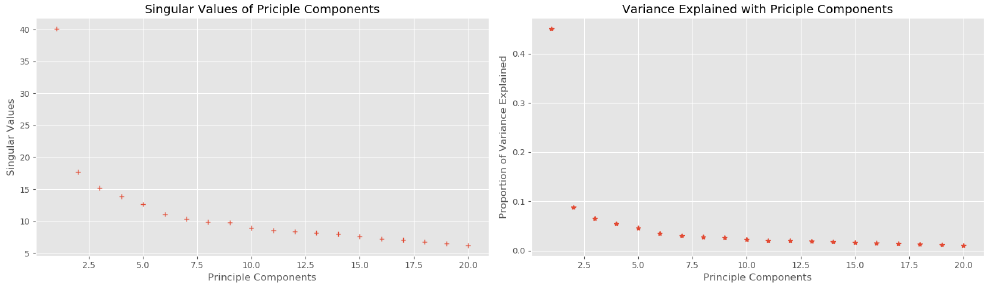
Figure 14. Principle Component Analysis over the aggregated data.